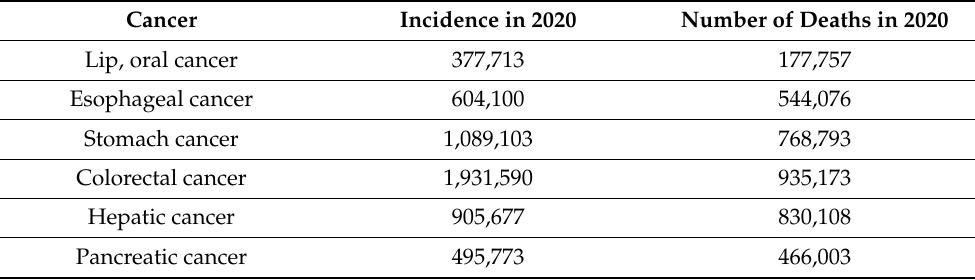
Table 1. Global GIT Cancer Statistics 2020 [88,89].